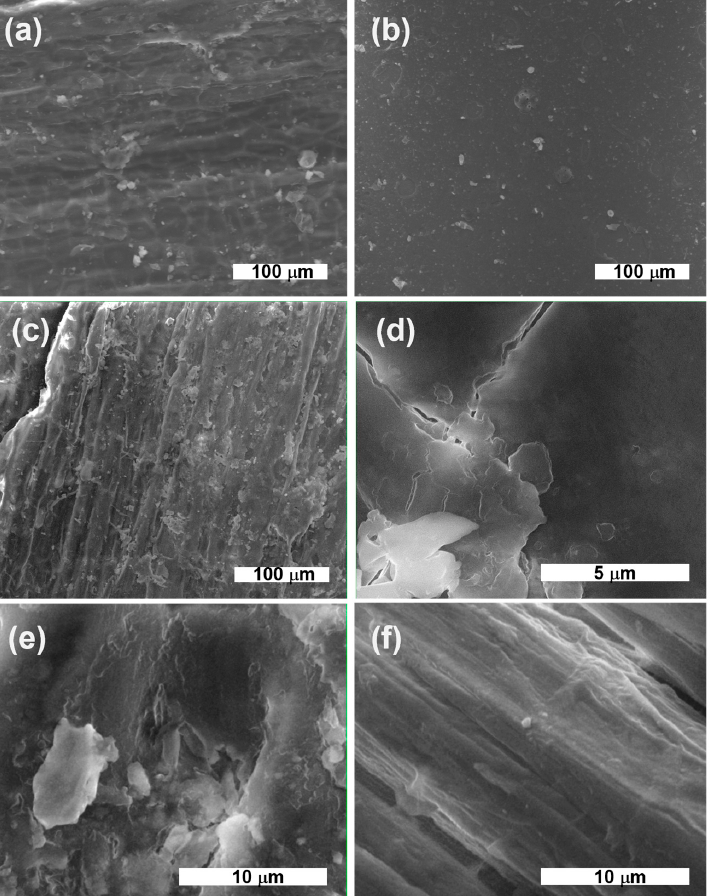
Figure 1. SEM images: HMP-STK target at deposition time ( a ) and the same HMP-STK target two years later ( c , e ); PLD-HMP-STK/Glass in 2020 ( b ) and in 2022 ( d ); thin film PLD-HMP-STK/HMP-FB as of 2022 ( f ).